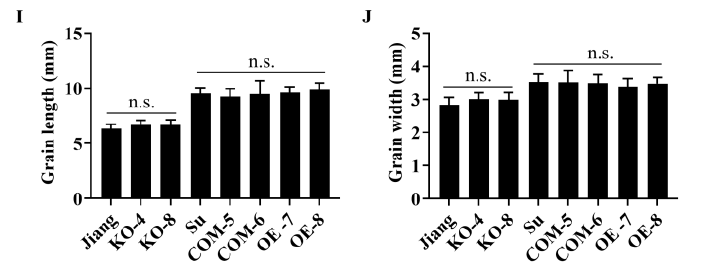
Figure 7. Pb2 does not affect rice agronomic traits. ( A , B ) Field growth status of WT and transgenic plants during filling period. ( C ) Plant height (cm). ( D ) Number of effective tillers (N). ( E ) Rice panicle length (cm). ( F ) Number of grains per panicle. ( G ) Seed setting rate (%). ( H ) 100-grain weight (g). ( I ) Grain length (mm). ( J ) Grain width (mm). Error bars represent standard deviation, differences between WT and experimental groups were tested with GraphPad Prism 8.3 t -test. n.s. represents not significant.